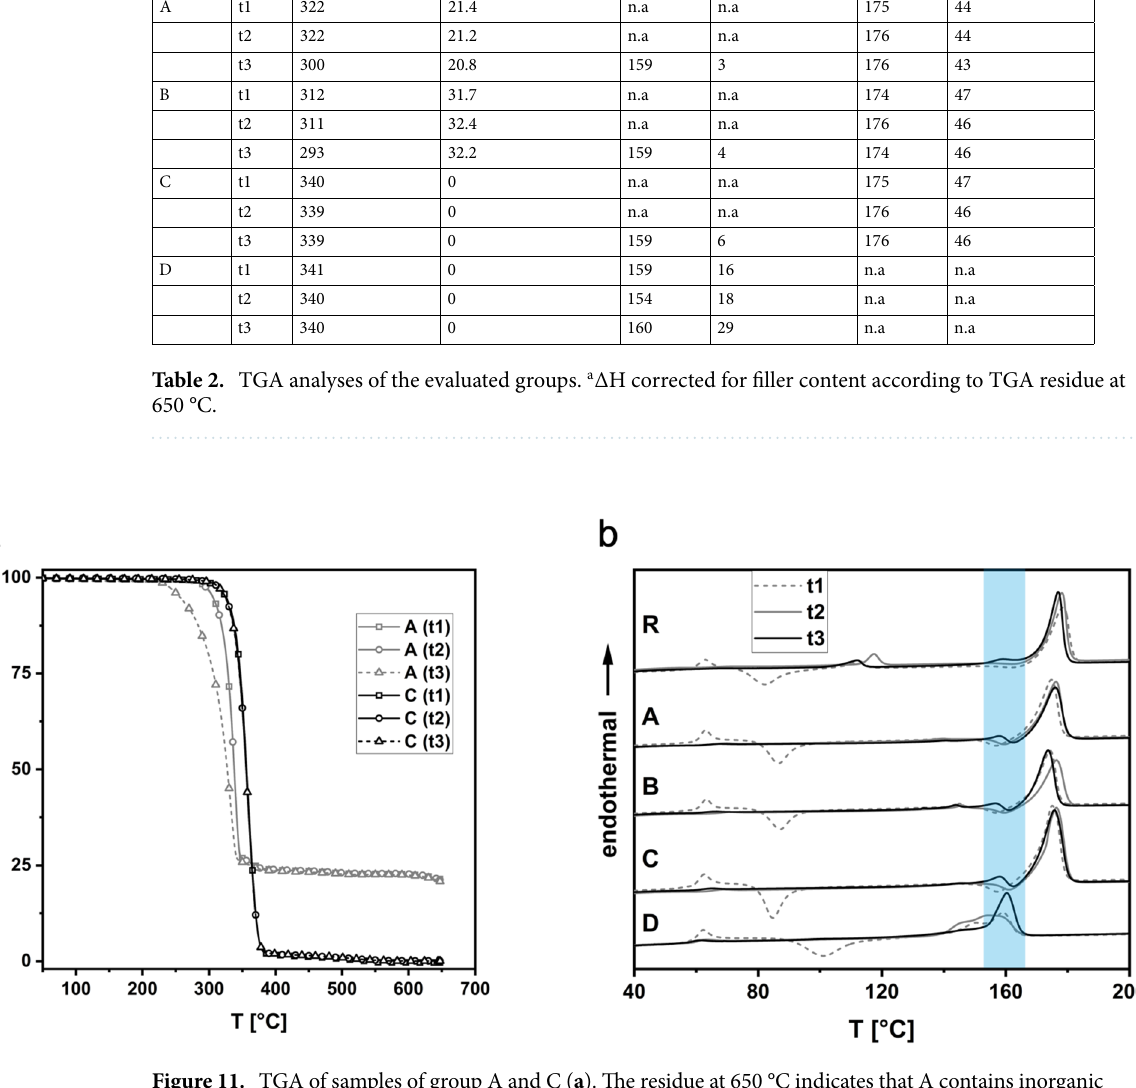
Figure 11. TGA of samples of group A and C ( a ). The residue at 650 °C indicates that A contains inorganic filler material. While C exhibits similar onset temperatures after printing (t1), annealing (t2), and sterilizsation (t3), A shows a significantly reduced onset temperature after t3 indicating a preceeding degradation or aging of the material; DSC first heating cycle (10 K min −1 ) of all samples after t1, t2, and t3 ( b ) with a blue bar marking the melting area of crystalline